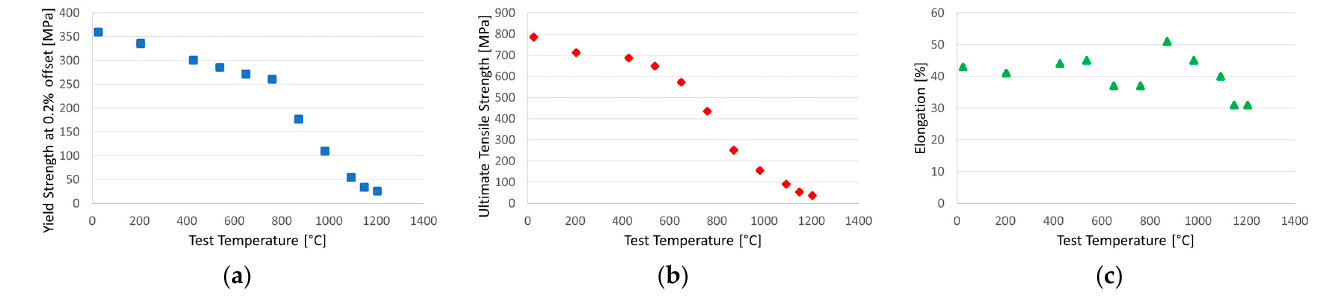
Figure 1. Average tensile data of Hastelloy X (2.8 mm thick sheet; heat ‐ treated at 1177 °C and rapid cooled): yield strength at 0.2% offset ( a ), ultimate tensile strength ( b ), elongation in 50.8 mm ( c ) [45].